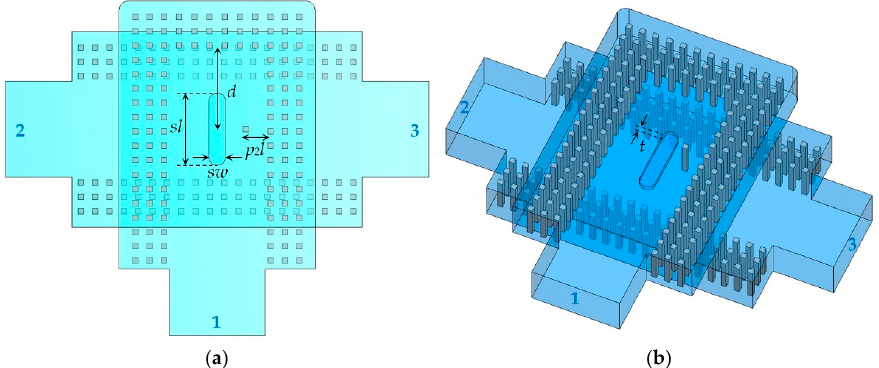
Figure 6. H-plane T-junction scattering parameters. S 21 and S 31 are identical. The E-plane T-junction geometry is shown in Figure 7. Port 1 lies in the upper layer, with ports 2 and 3 in the lower layer. These layers are coupled by means of a symmetrical slot excited by a post with the same dimensions of the GGW pins. The GGW short distance with respect to the slot center is optimized for impedance matching. Internal edges are rounded with a blending radius of 2 mm. The E-plane T-junction geometrical parameters and simulated scattering parameters are reported in Table 3 and Figure 8, respectively. The return loss is better than 20 dB from 9.24 to 9.81 GHz, corresponding to a 5.98% frac- tional bandwidth. Equal power division is observed in the same frequency interval.